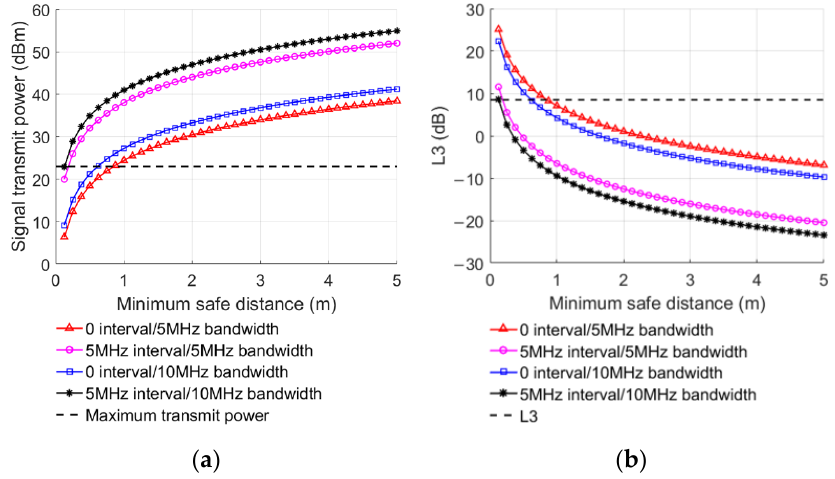
Figure 8. Influencing factors when UE interfering with BS: ( a ) transmitting power of interference signal, ( b )